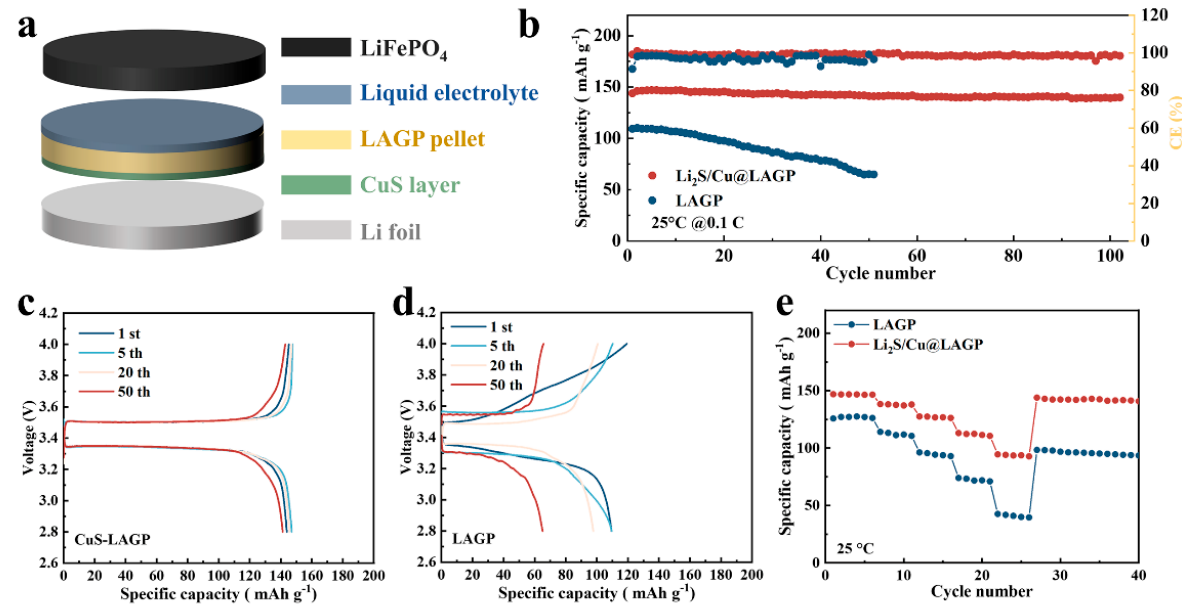
Figure 8. Electrochemical performances of full cells based on the Li anode and LFP cathode at a constant temperature of 25 ◦ C. ( a ) Scheme of the Li|Li 2 S/Cu@LAGP|LFP full cell assembly. ( b ) Comparison of the cyclic stability of two types of full cells at 0.1 C. Charge–discharge curves at the 1st, 5th, 20th, 50th, and 100th cycles at 0.1 C for ( c ) Li|LAGP|LFP and ( d ) Li|Li 2 S/Cu@LAGP|LFP cells. ( e ) Rate performances of two types of full cells.